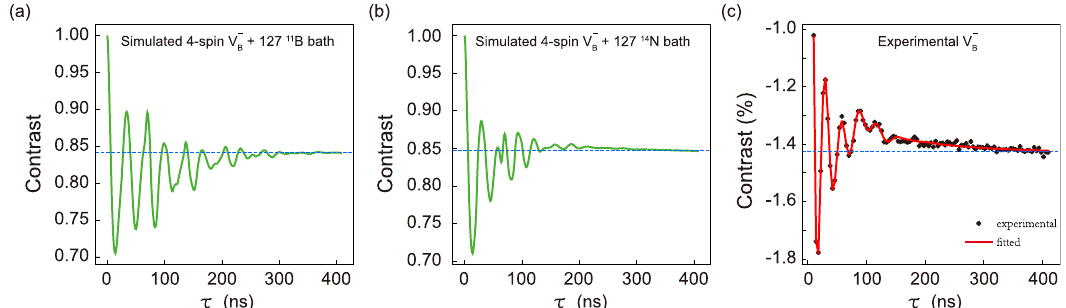
Fig. 5 | Spin dynamics of open V (cid:1) B system with relaxation from the many-body nuclear spin bath at B =21.7 mT. a , b Theoretical Rabi oscillation interacted with the surrounding 127 14 N or 11 B as the many-body spin bath. The dashed lines are provided as a baseline of long-time background. c Experimental Rabi oscillation